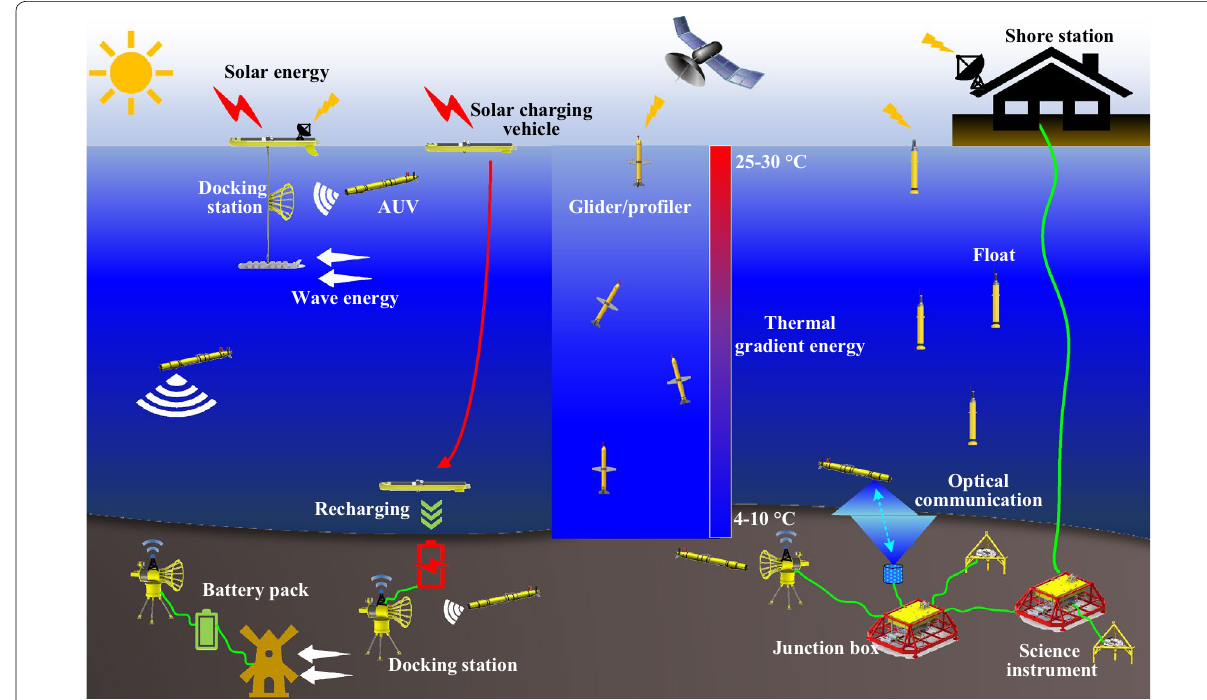
Figure 10 Concept of the future ocean observing